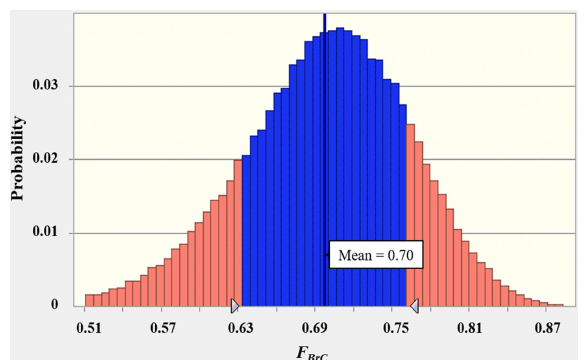
Figure 6. The probability distribution of calculated F BrC-entire . Assuming that the AAE -contained value of 2 . 46 ± 0 . 16 (mean ± SD of the means) and AAE -open value of 3 . 44 ± 0 . 42 (mean ± SD of the means) apply to global biomass burning, the com- bined value for all biomass burning ( F B-entire ) can be calcu- lated as F BrC-entire = 0 . 71 × ( 0 . 5519lnAAE -open + 0 . 0067 ) + 0 . 29 × ( 0 . 5519lnAAE -contained + 0 . 0067 )